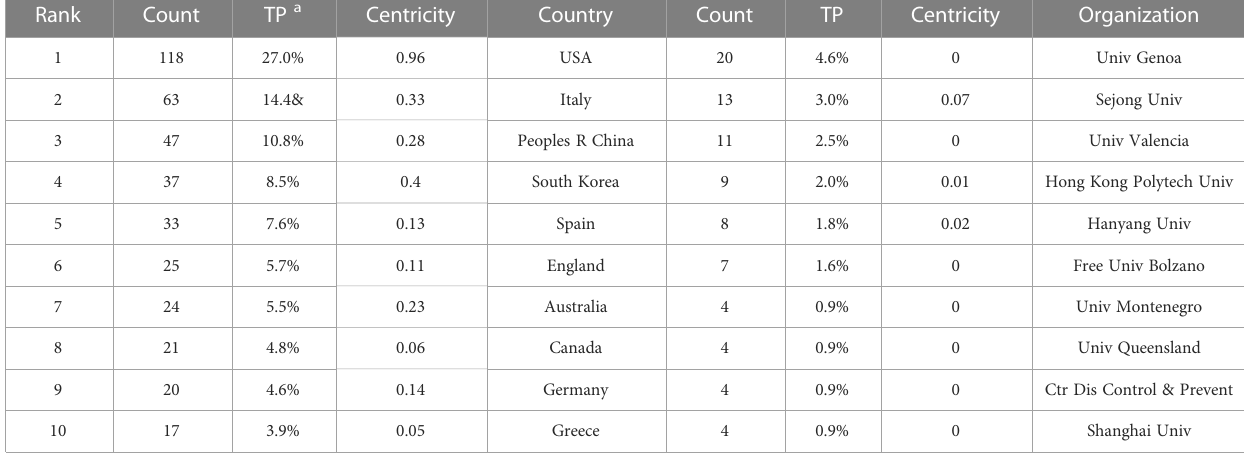
TABLE 1 Top ten countries and organizations in cruise research.